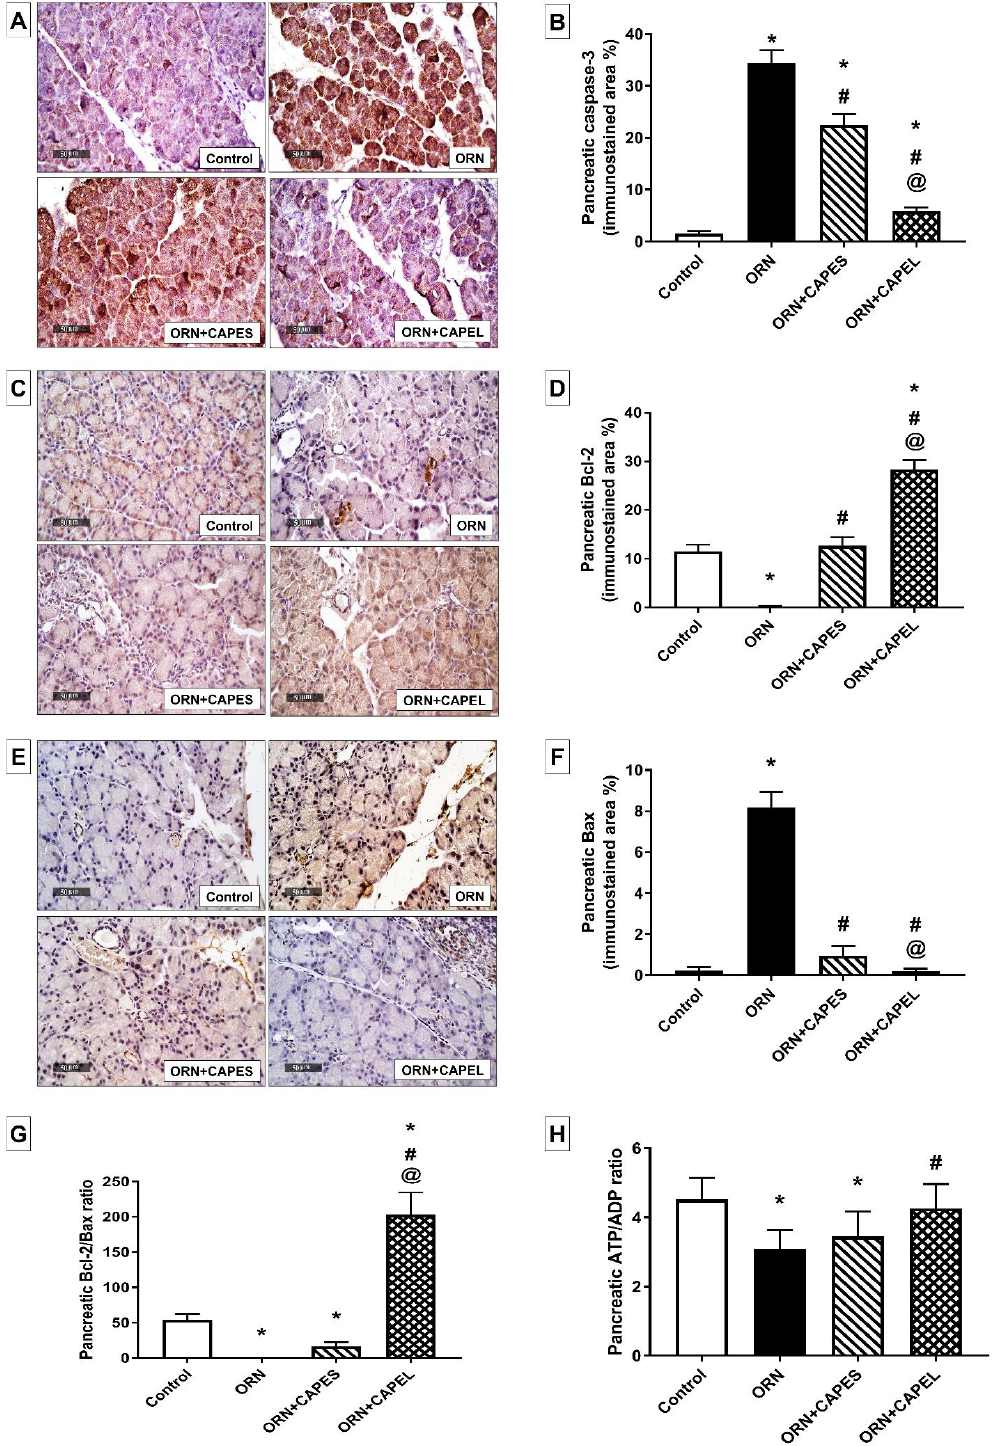
Figure 6. Effect of administering caffeic acid phenethyl ester (CAPE)-optimal liposomal formulation (CAPEL) on pancreatic apoptosis and energy status in rats with ornithine-induced acute pancreatitis. ( A ) Representative photomicrographs of the immunohistochemical evaluation of pancreatic